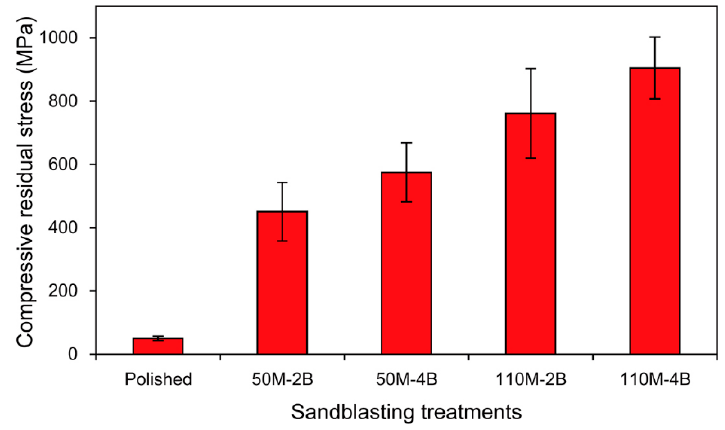
Figure 5. Compressive residual stresses for the polished and sandblasted zirconia surfaces.